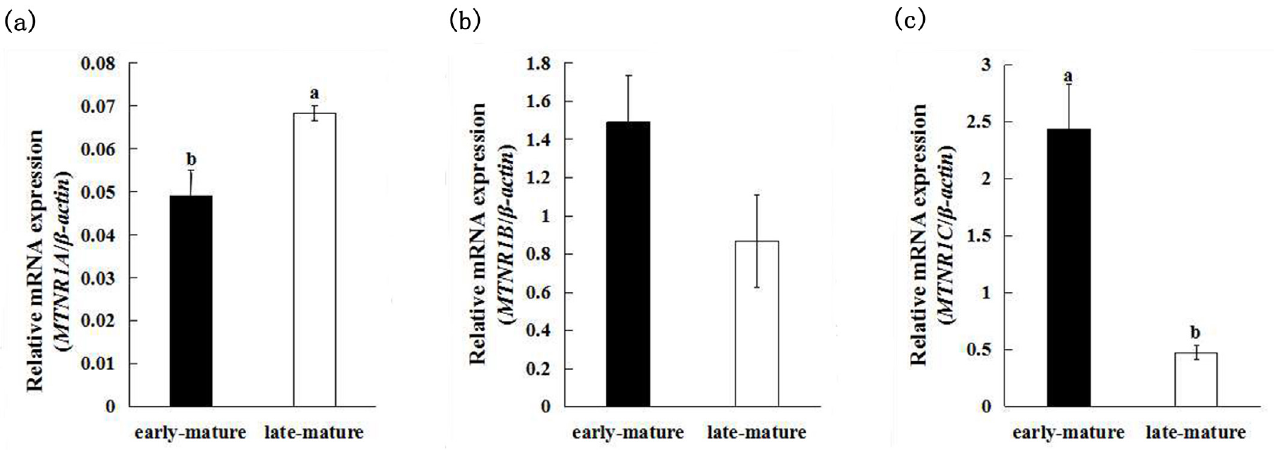
Figure 2. Results of expression of melatonin receptor subtypes mRNA in ovaries between early-mature group and late-mature group. (a) Comparison of mRNA expression of MTNR1A in ovaries between early-mature group and late-mature group. (b) Comparison of mRNA expression of MTNR1B in ovaries between early-mature group and late-mature group. (c) Comparison of mRNA expression of MTNR1C in ovaries between early-mature group and late-mature group. MTNR1A, MTNR1B, MTNR1C, melatonin